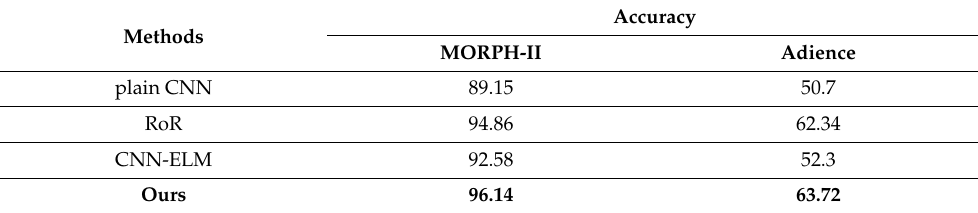
Table 4. Age grouping accuracy (%) by using different methods based on two datasets.